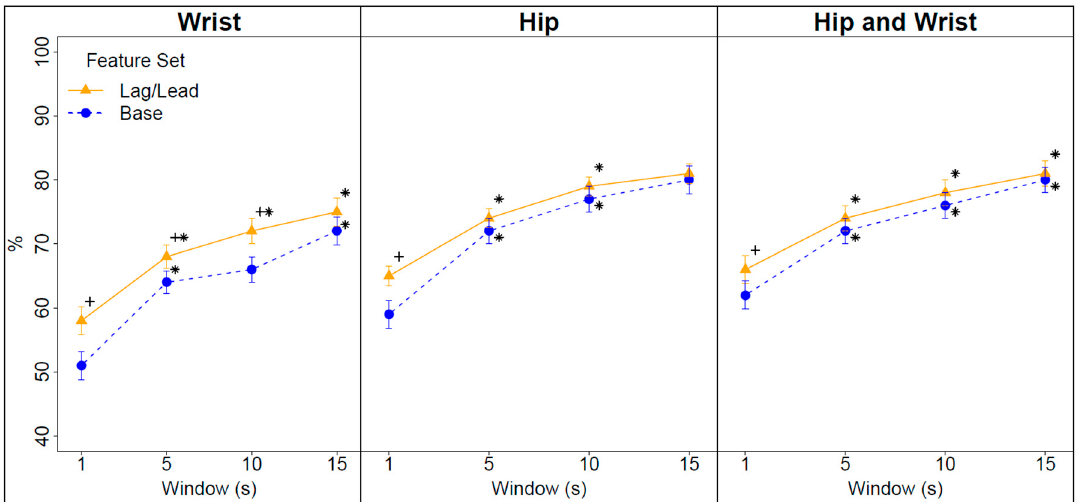
Figure 1. Interaction plots summarizing the effect of window size and feature set on the adjusted F-scores for models trained on wrist, hip, and combined hip and wrist accelerometer data. + Denotes significantly different from the base model at a given window size p < 0.05; * Denotes significantly different from the previous window size for a given feature set p < 0.05.